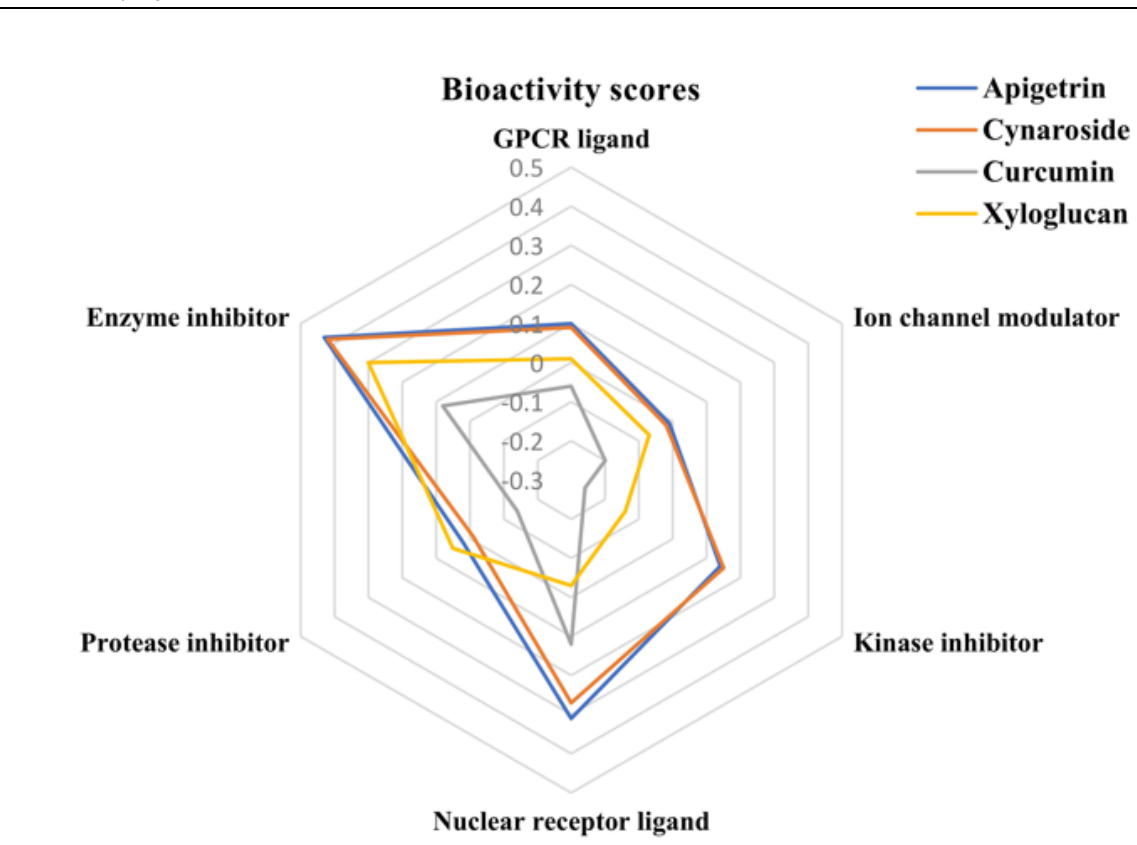
Figure 13. Bioactivity scores of apigetrin, cynaroside, curcumin and xyloglucan.